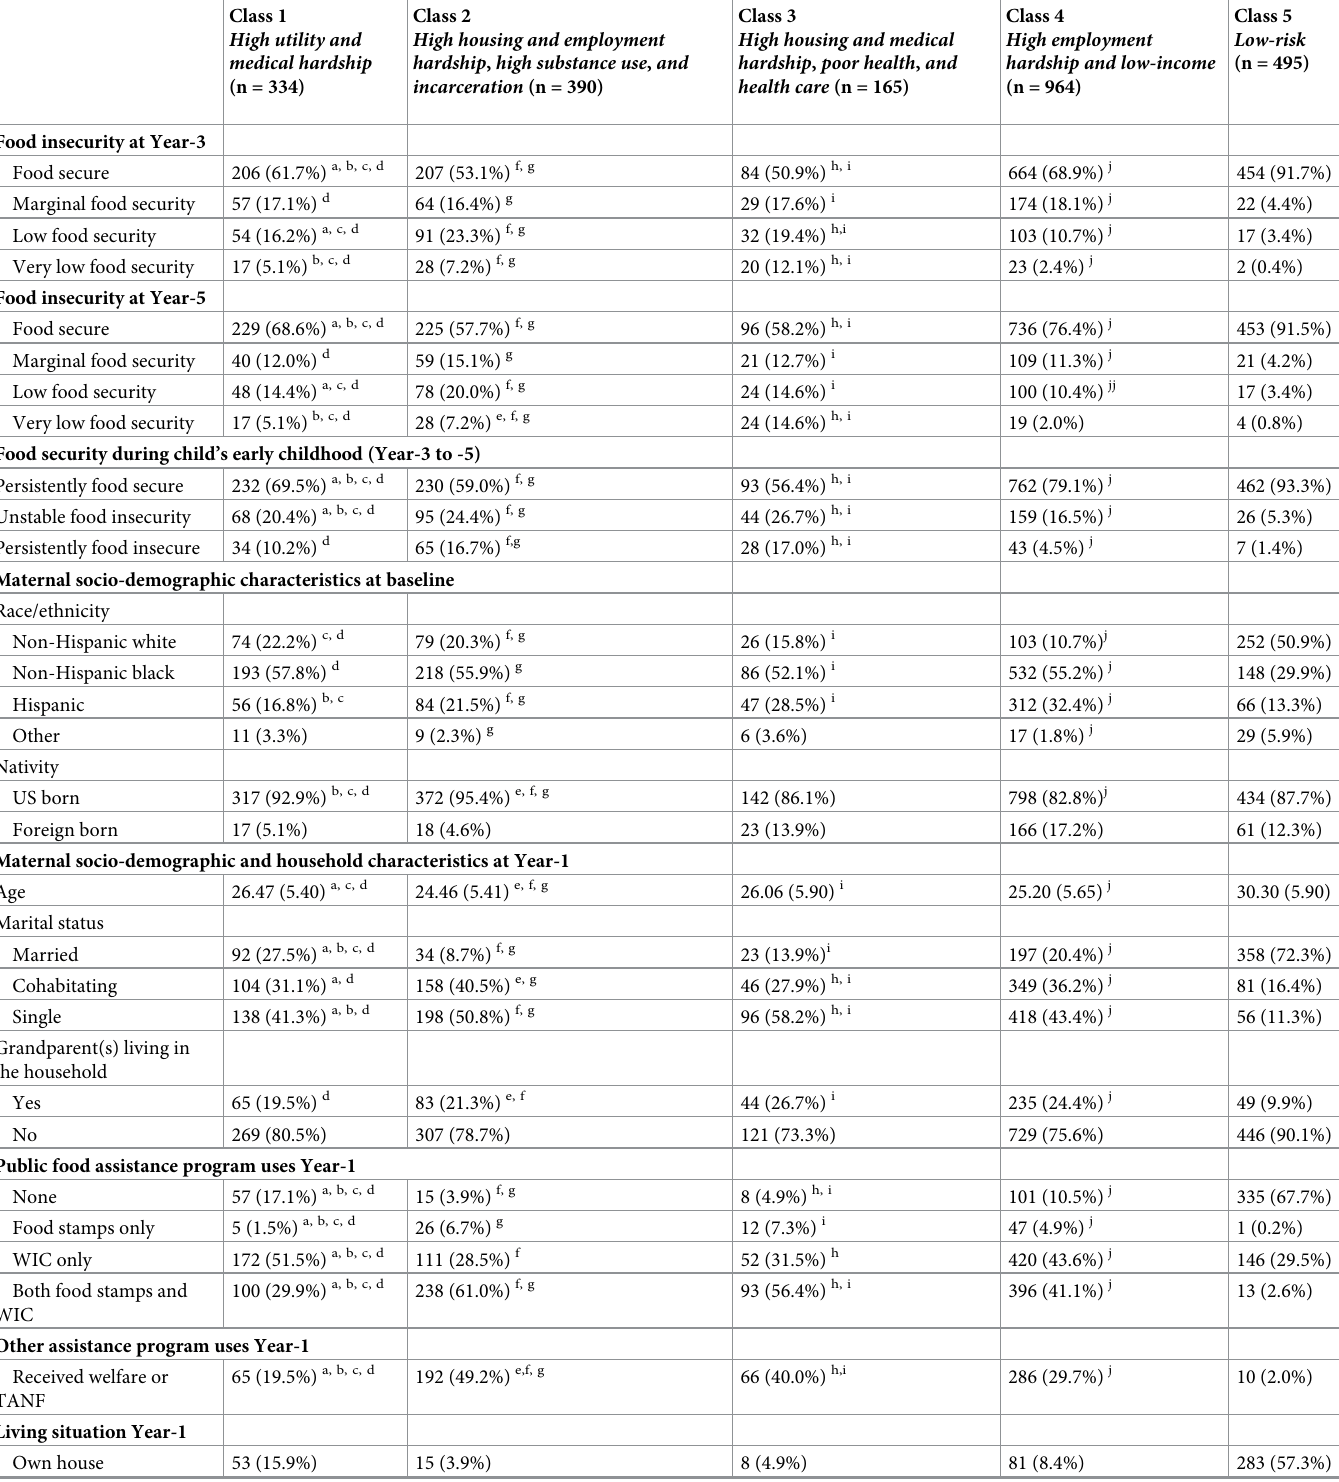
Table 4. The food security status, socio-demographic and household characteristics of the five latent classes identified in the LCA (n =